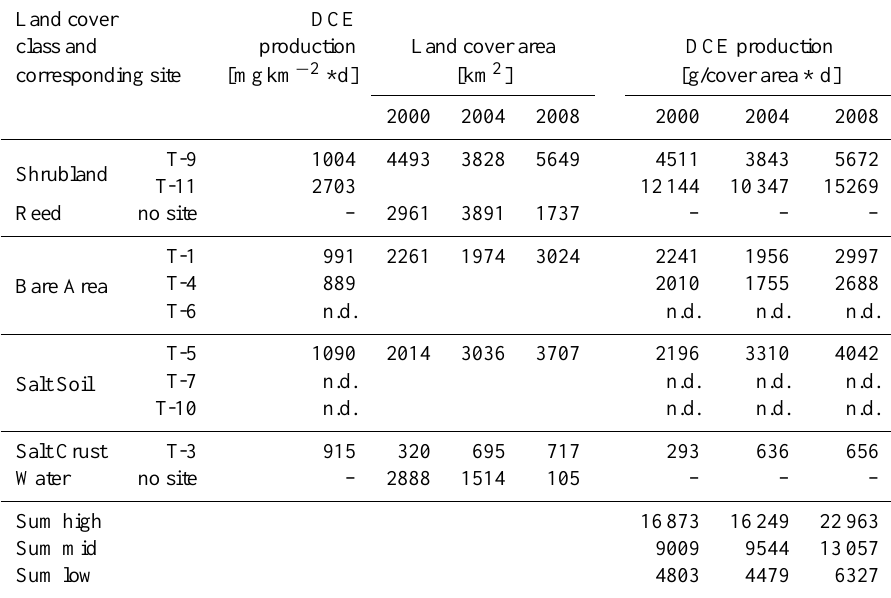
Table 2. Estimated production of trans 1,2-DCE for the research area (ca. 15000km 2 ) based on 0–2cm soil profile data. Determined DCE production within 24h after humidification of the soil sample. Production rates are given for each land cover class in g DCE/covered area and day.